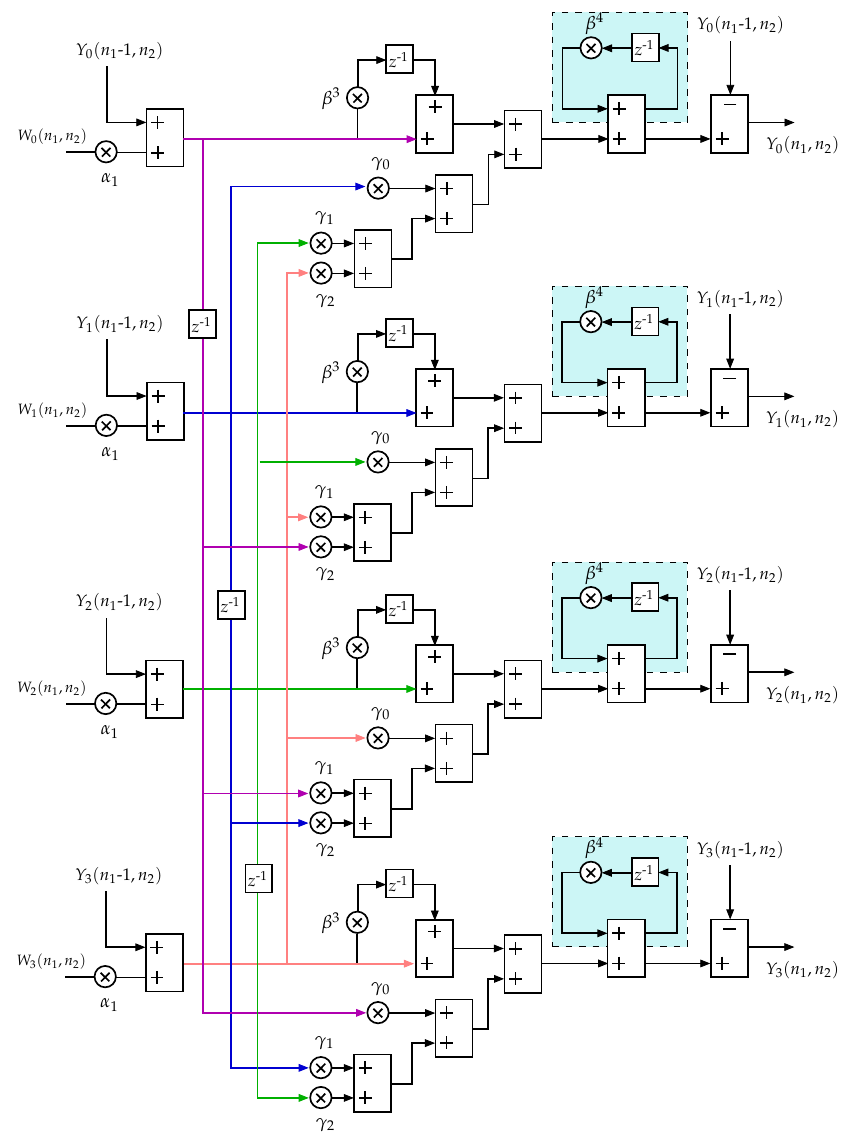
Figure 5. The time-interleaved polyphase PPCM block of the systolic array based four-phase 2D IIR beam